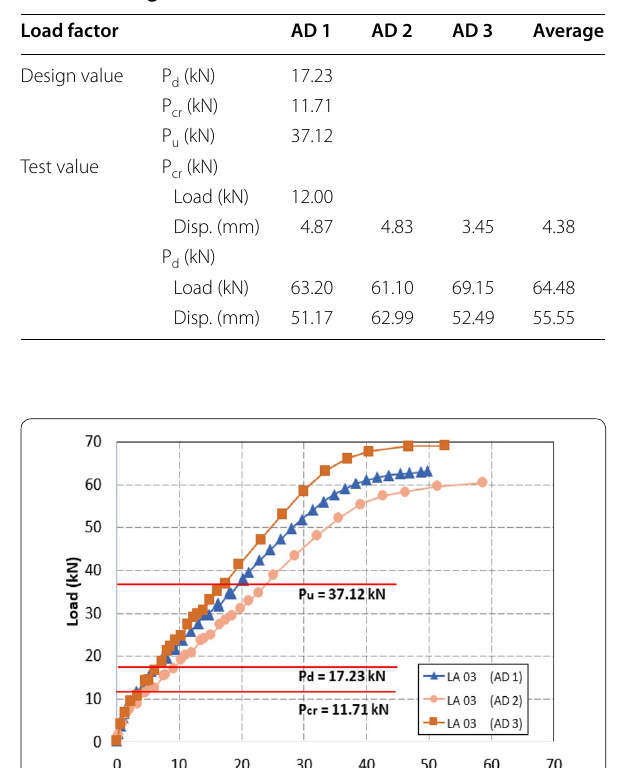
Table 3 Design-test data (AD).